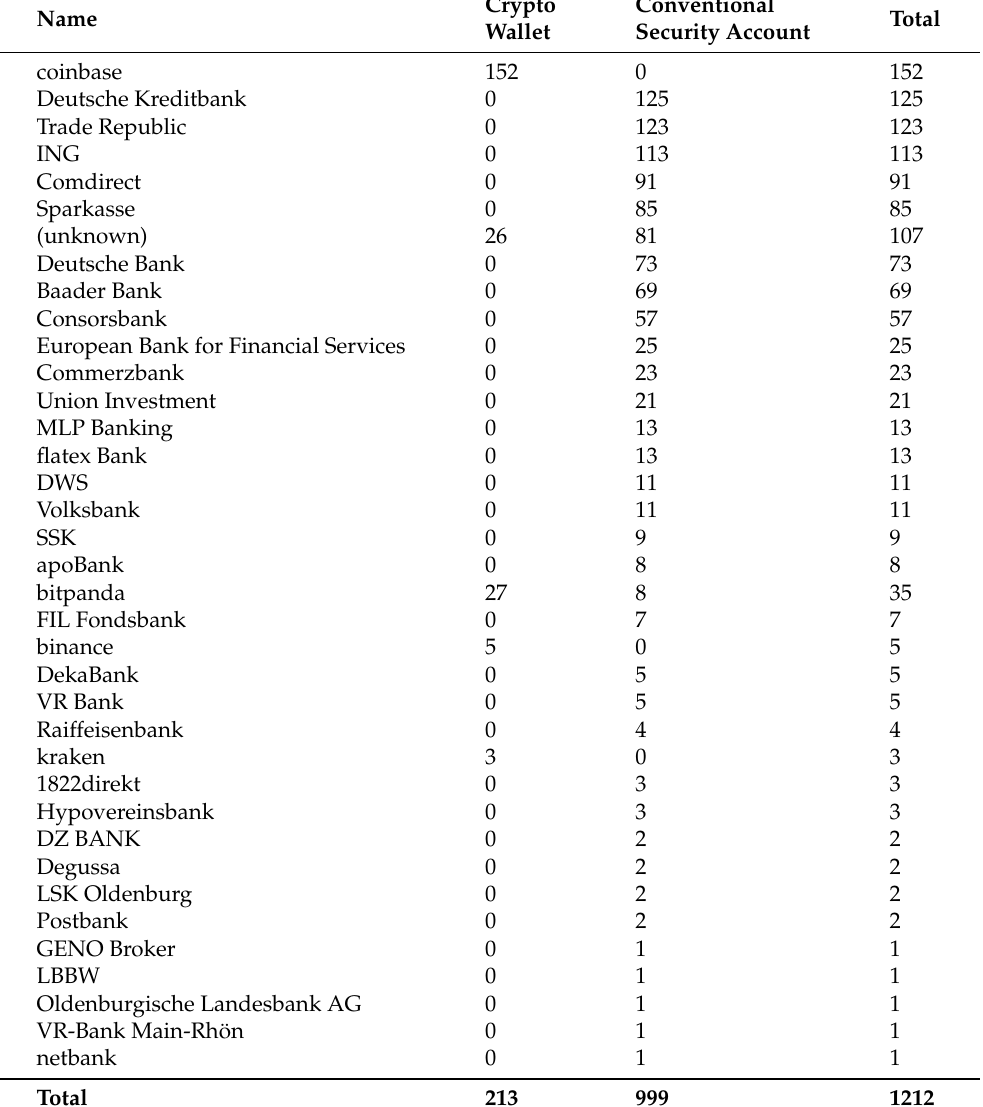
Table A13. Frequencies of crypto wallets & conventional security account. Source: Own data.